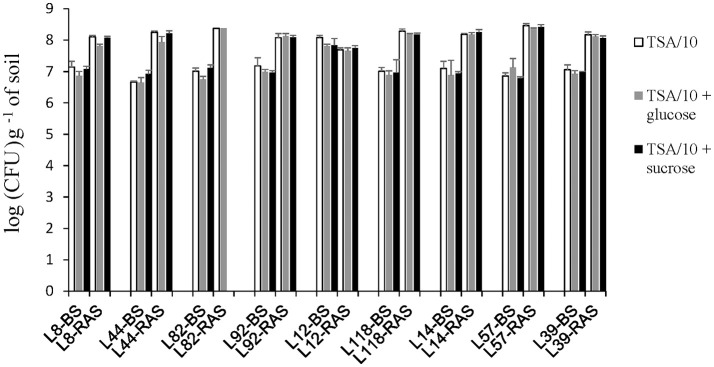
Enumeration of bacterial microbiota on TSA/10 (in white). TSA/10 + glucose (in gray) and TSA/10 + sucrose (in black) expressed in colony-forming units (CFU) per gram of bulk soil (-BS) or root-adhering soil (-RAS). Missing data for the treatment L82.